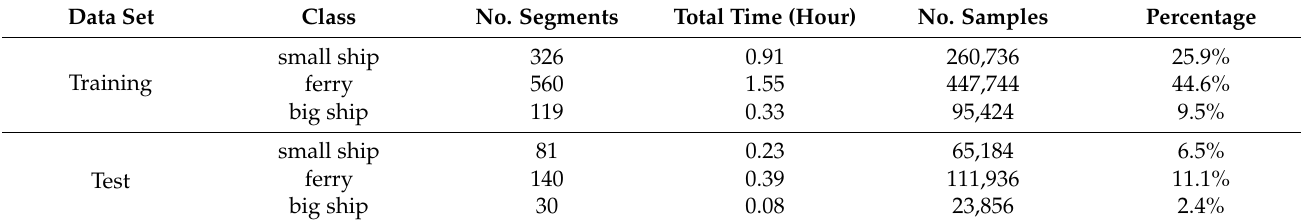
Table 1. The experimental data